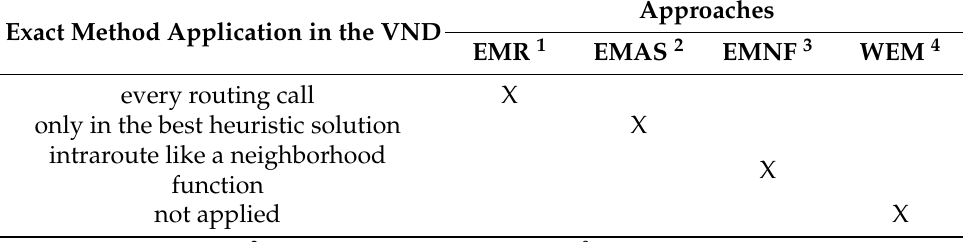
Table 1. Differences among the proposed